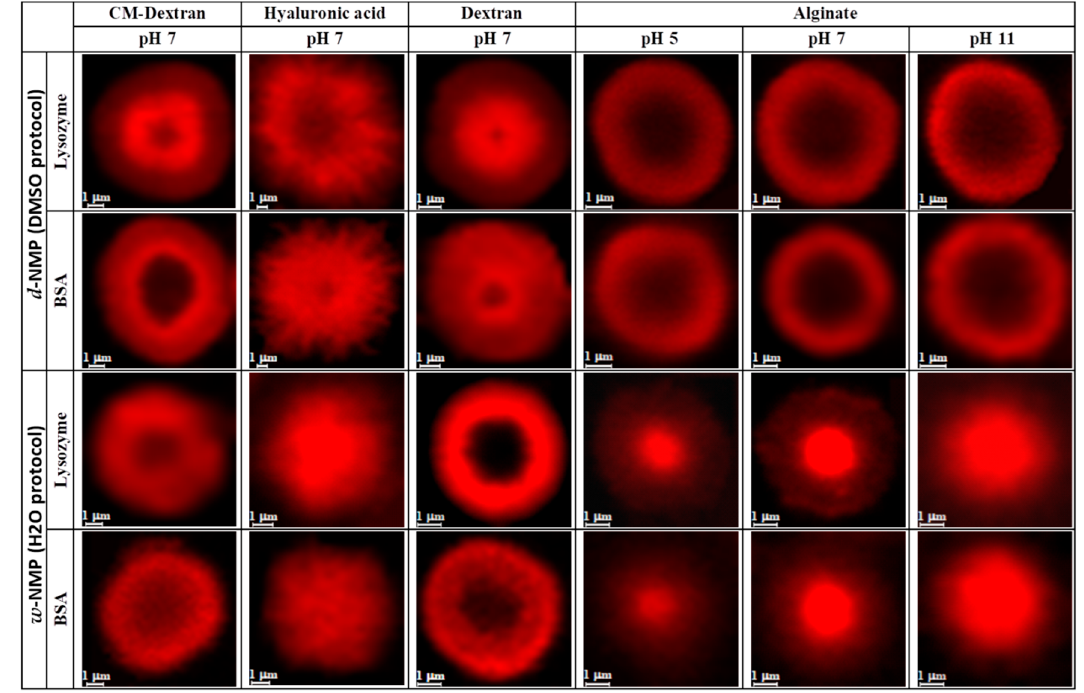
Figure 6. Confocal micrographs of RITC labeled lysozyme and BSA adsorbed by NMPs at pH 7. For alginate, pH 5 and 11 are also shown to highlight strong dependence of adsorption on pH value.